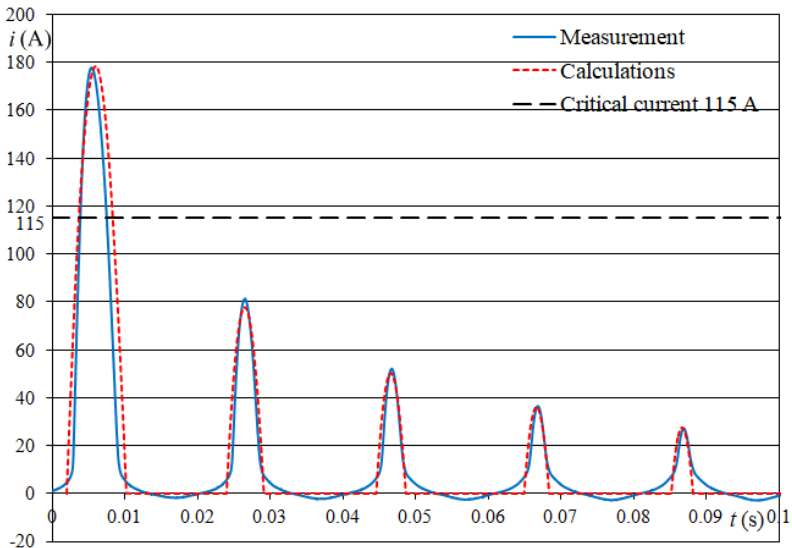
Figure 16. Five consecutive impulses of inrush current of 8.5 kVA HTS transformer, measured and calculated.